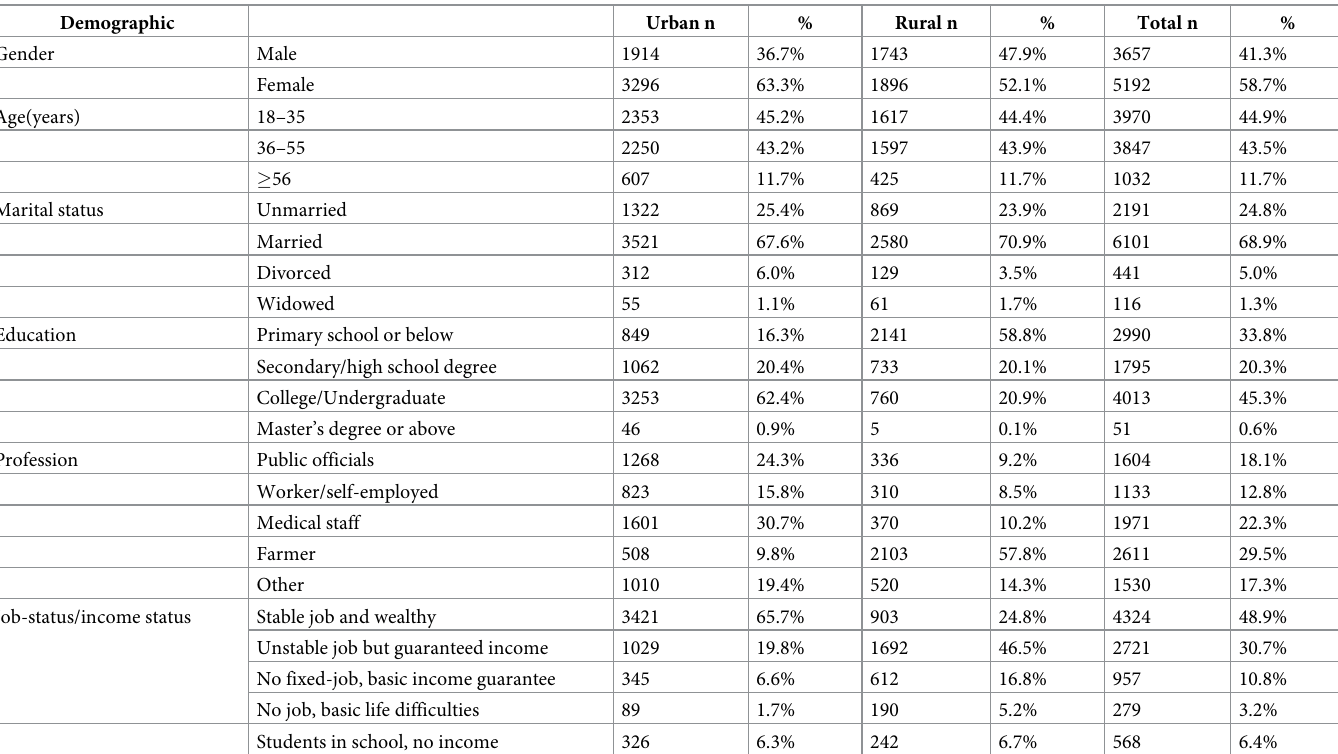
Table 1. Basic characteristics of the surveyed urban and rural population (n =